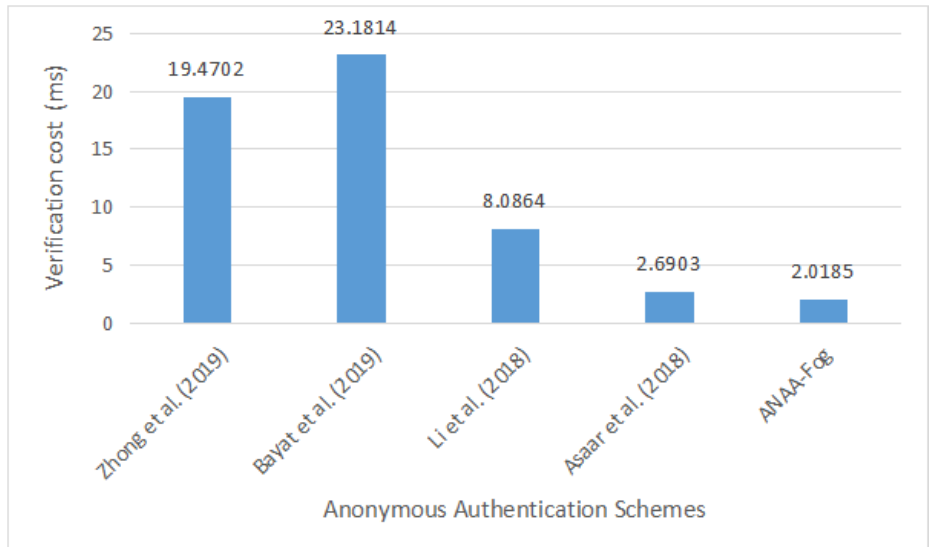
Figure 6. Verifying a single signature involves a large amount of